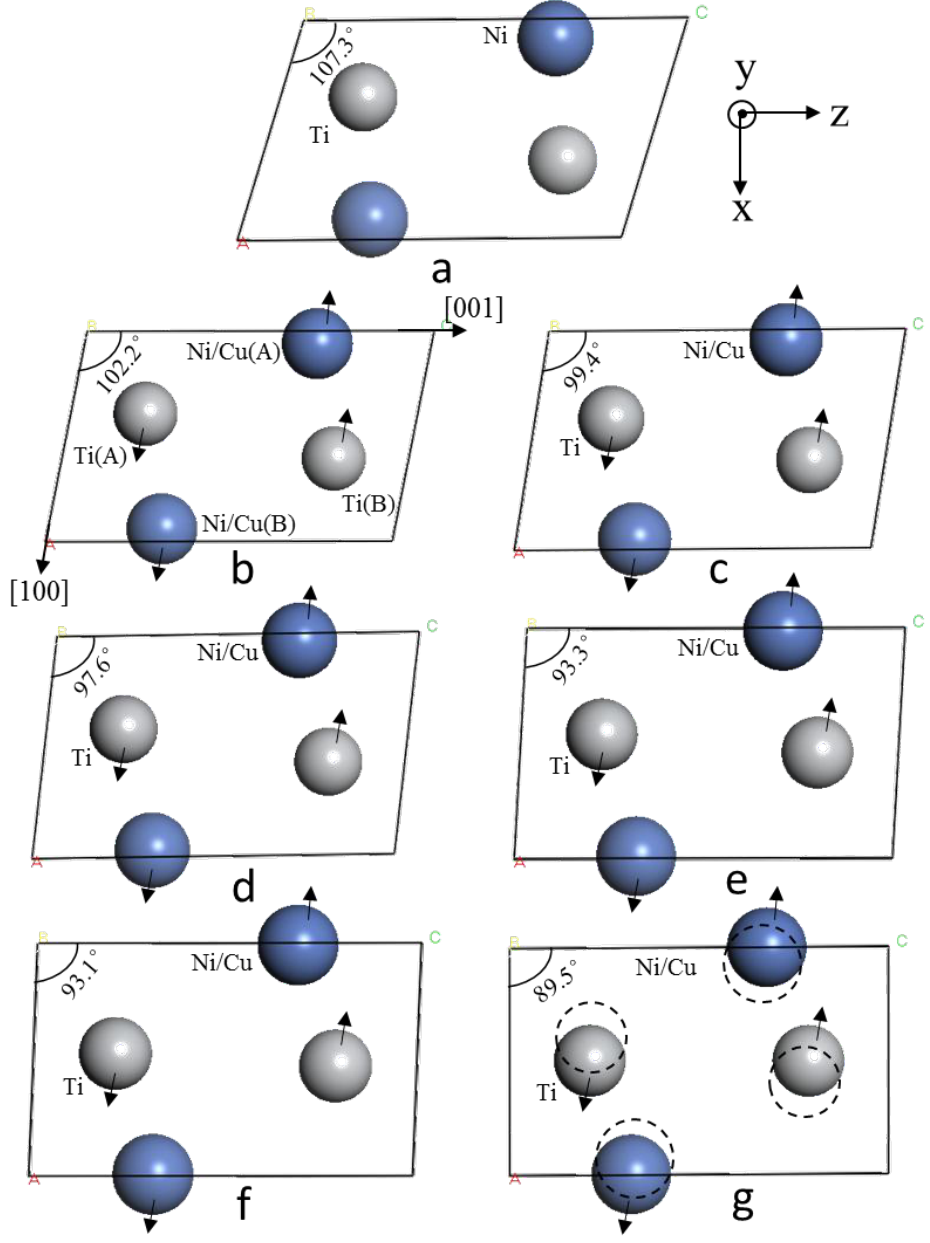
Figure 2. Projections of the martensite crystal structures along the <010> direction of ( a ) binary Ti 50 Ni 50 ; ( b ) Ti 50 Ni 45 Cu 5 ; ( c ) Ti 50 Ni 37.5 Cu 12.5 ; ( d ) Ti 50 Ni 35 Cu 15 ; ( e ) Ti 50 Ni 31.25 Cu 18.75 ; ( f ) Ti 50 Ni 30 Cu 20 ; and ( g ) Ti 50 Ni 25 Cu 25 , comparing the typical relative average positions of the Ni site (blue) and Ti site (grey) along ‘ a ’ and ‘ c ’ lattice parameters with respect to the binary